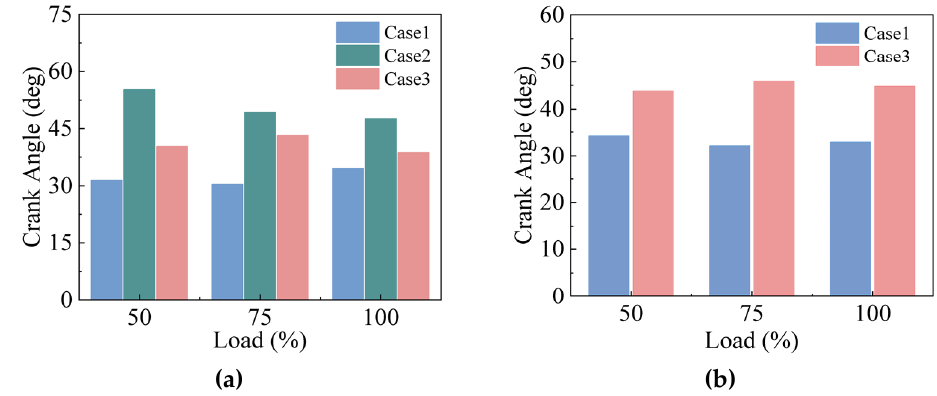
Figure 6. CA90-CA5 for variable EBP at different loads. ( a ) EBP = 10 kPa; ( b ) EBP = 25 kPa.